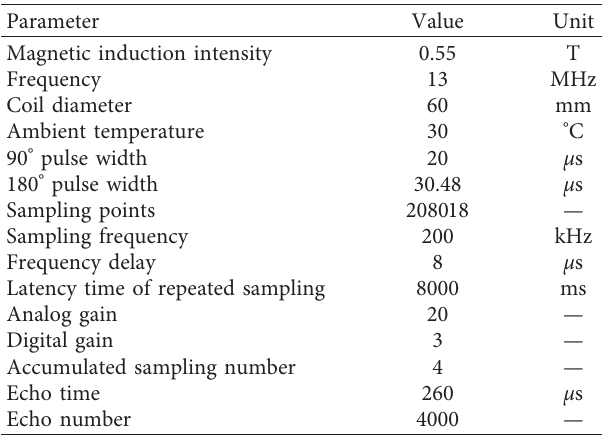
Figure 2: Composition of the MesoMR12-150H-I NMR analyzer [21]. Table 2: Parameters of the NMR